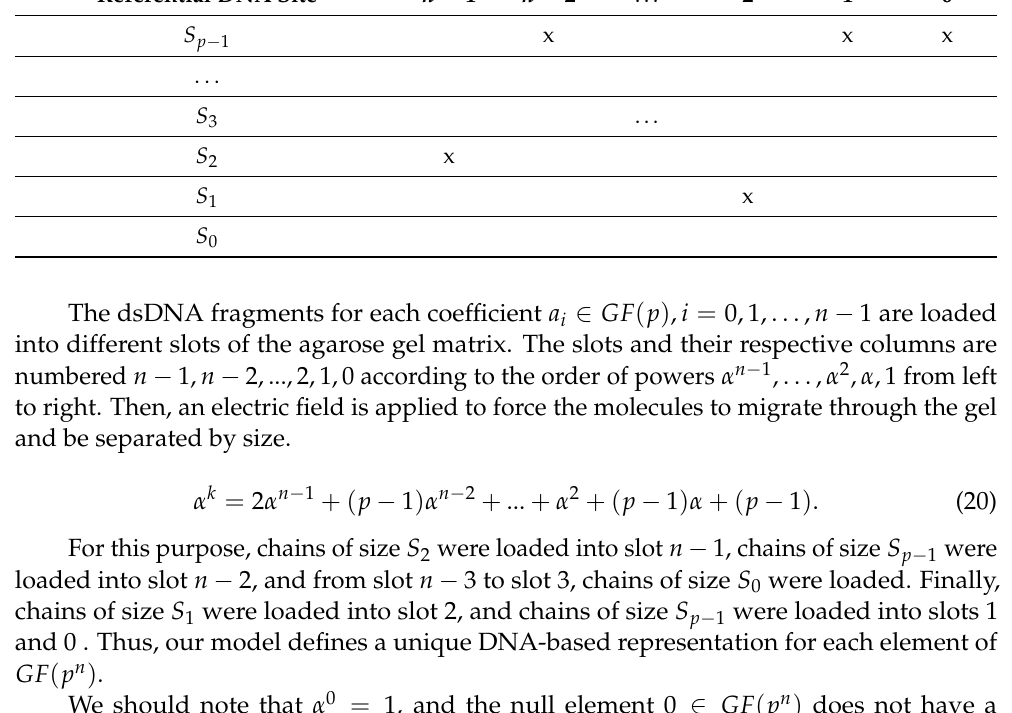
Table 2. dsDNA fragment representation of α k performed by agarose gel electrophoresis. Positions of the Coefficients α k ∈ GF ( p ) Referential DNA Site